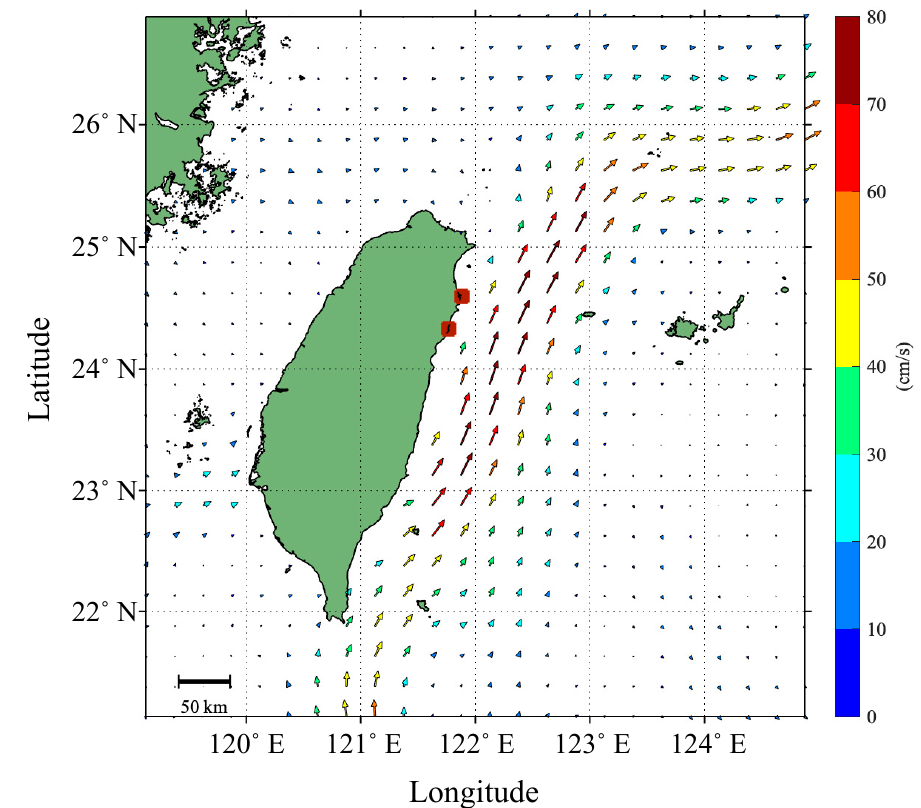
Figure 2. Mean surface geostrophic velocity (SGV) in 2013.